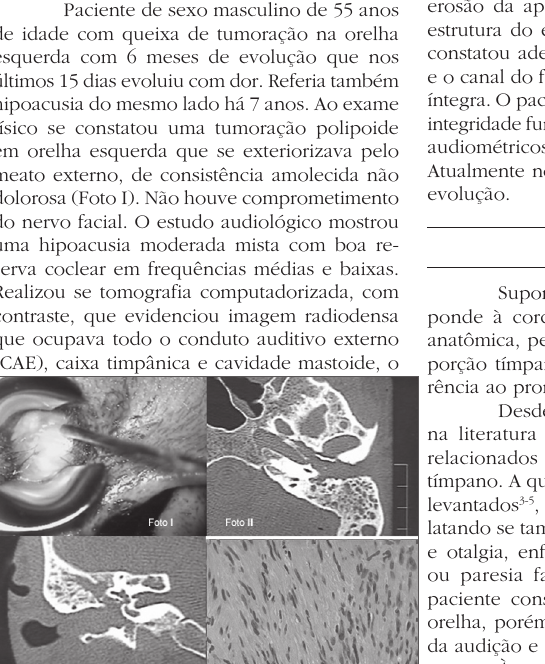
Foto. I: Tumoração polipoide em orelha esquerda que se exte- rioriza pelo CAE. Foto II y III: Tomografia computadorizada